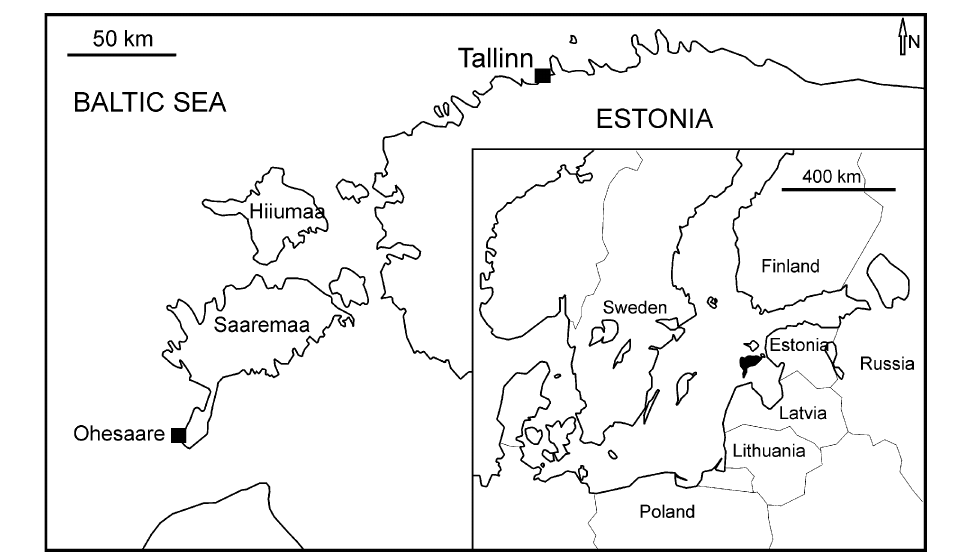
Fig. 1. Location of the Ohesaare cliff with Cruziana